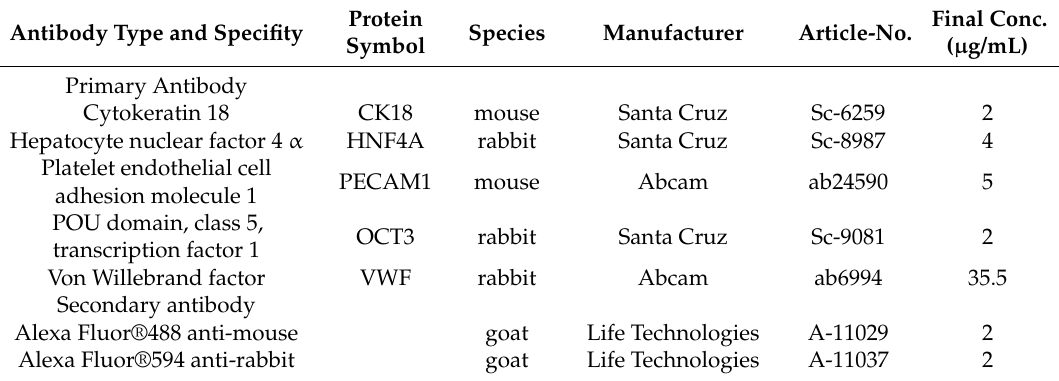
Table 4. Primary and secondary antibodies used for immunofluorescence